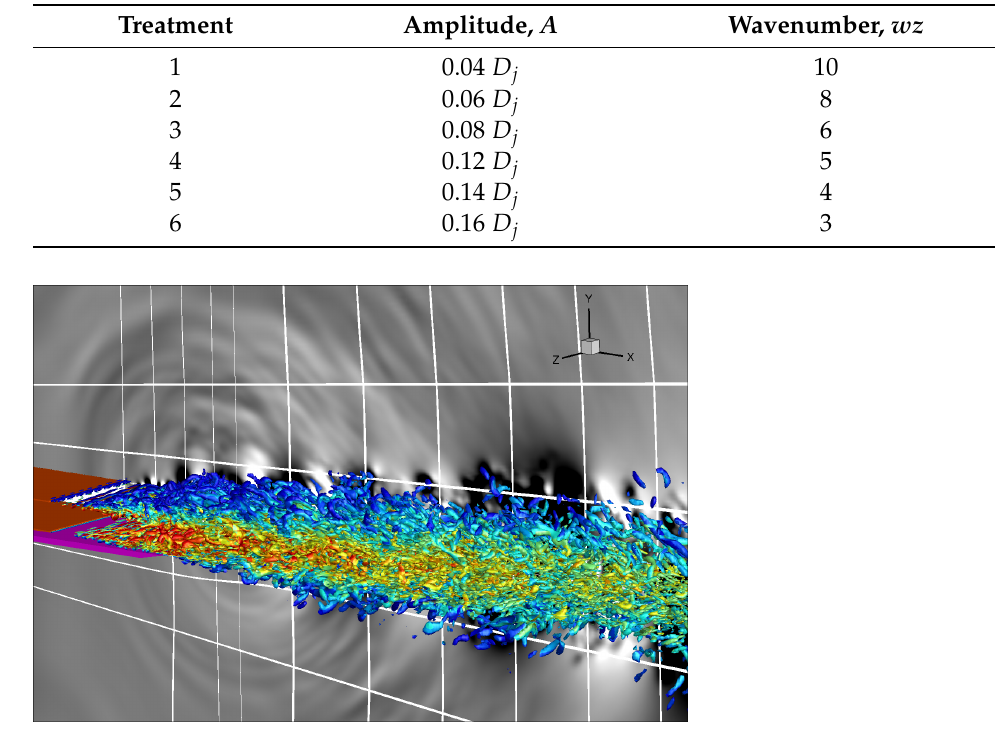
Figure 7. Iso-surfaces of Q-criterion colored by the streamwise velocity and pressure contours in gray. The mean centerline velocity distributions are compared against RANS results in Figure 8. While there are some slight differences between the two in the potential core region, overall the agreement is good, showing similar decay in the downstream flow. (The LES profiles show some fluctuations from insufficient time spans used for the time averaging).